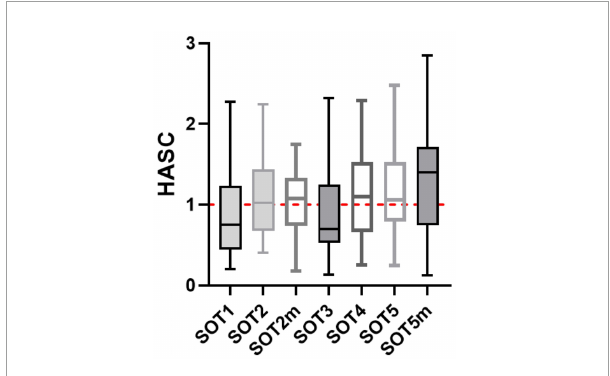
FIGURE12 Hip/ankle strategy contribution (HASC) changes between L-30 and R + 3. In ordinate: ratio of hip/ankle strategy involvement indicator (after flight/before